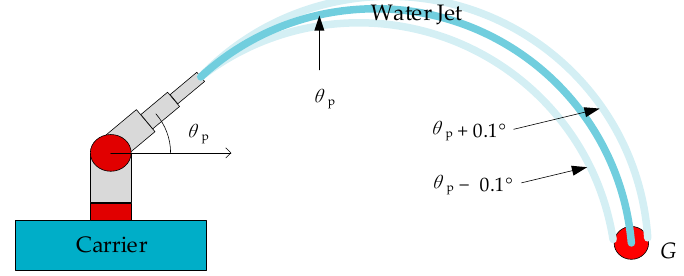
Figure 6. Schematic diagram of jet shooting.